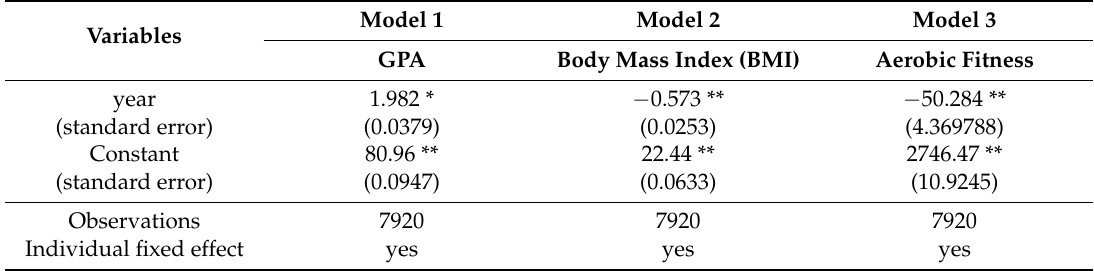
Table 2. Academic achievement trajectory. Body Mass Index (BMI) and aerobic fitness